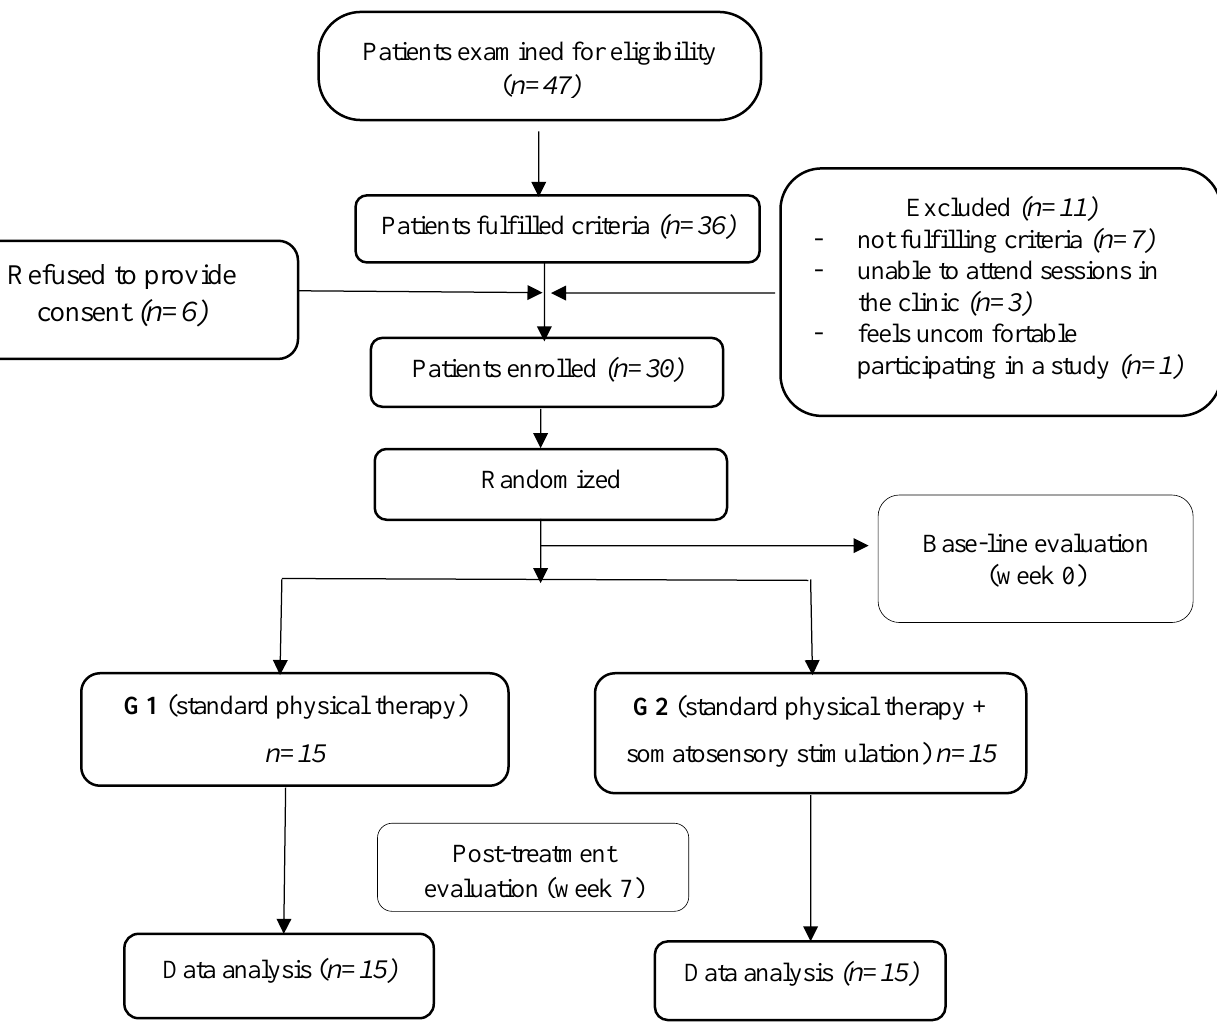
Figure 1. Diagram showing the flow of the study.